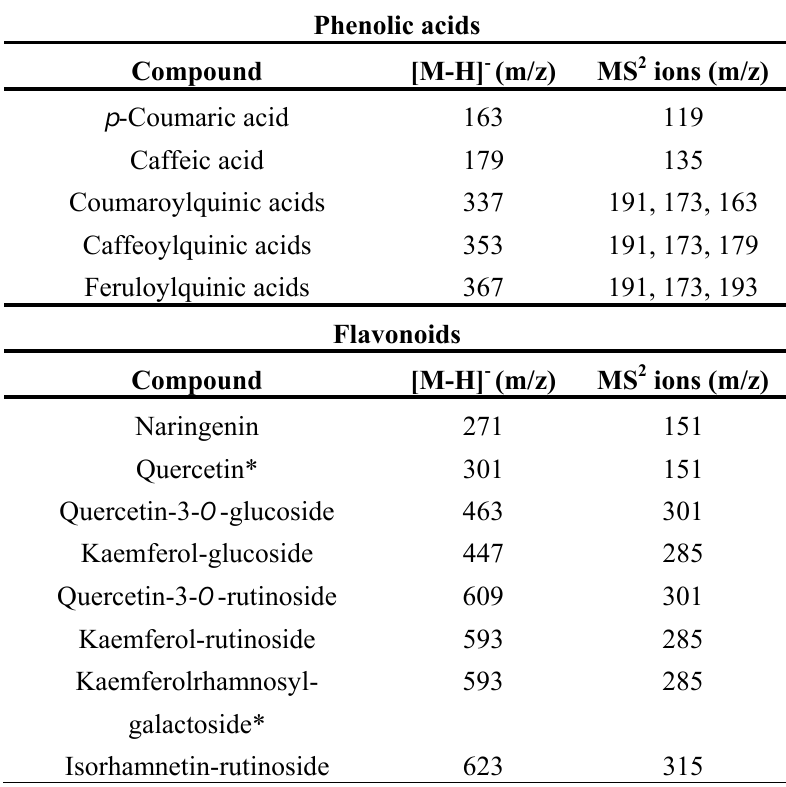
Table 4. Mass spectral characteristics of phenolics identified in Solanum indicum L.